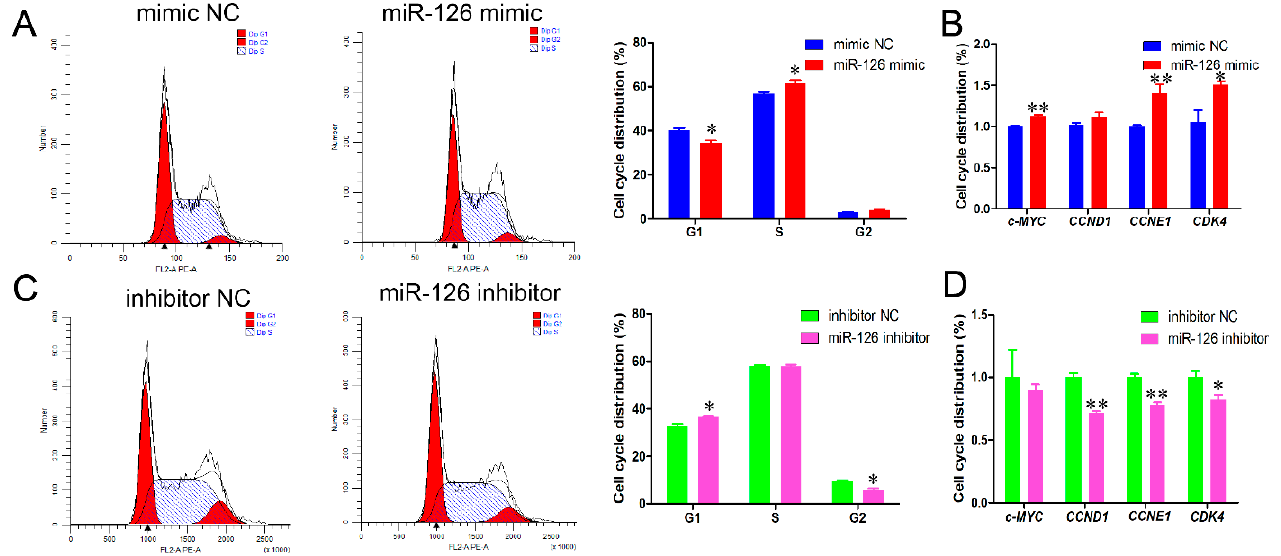
Figure 1. miR-126 promotes the cell cycle progression of immature porcine Sertoli cells. The immature porcine Sertoli cells were transfected with miR-126 mimic/mimic NC or miR-126 inhibitor/inhibitor NC respectively. ( A , C ) The effects of miR-126 overexpression ( A ) and miR-126 inhibition ( C ) on the distribution of G1, S and G2 phases in the cell cycle. Cell cycle phase was analyzed 24 h after transfection by a FACSCanto II Flow Cytometer ( n = 3). ( B , D ) The mRNA levels of cell cycle-related genes, c-MYC , CCNE1 , CCND1 and CDK4 , were detected in cells transfected with miR-126 mimic ( B ) or miR-126 inhibitor ( D ) using a qPCR assay ( n = 3). The pig-TBP gene was used as the internal control. All data are shown as the mean ± SEM, * p < 0.05 and ** p <